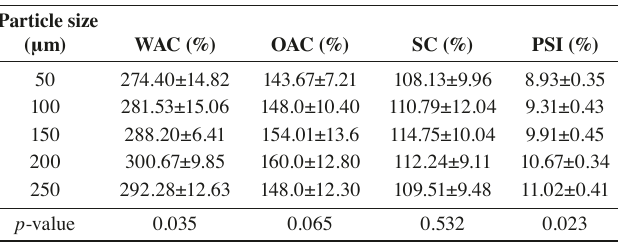
Tab. 1: Functional properties of non-irradiated N. nucifera rhizome at diffe - rent particle